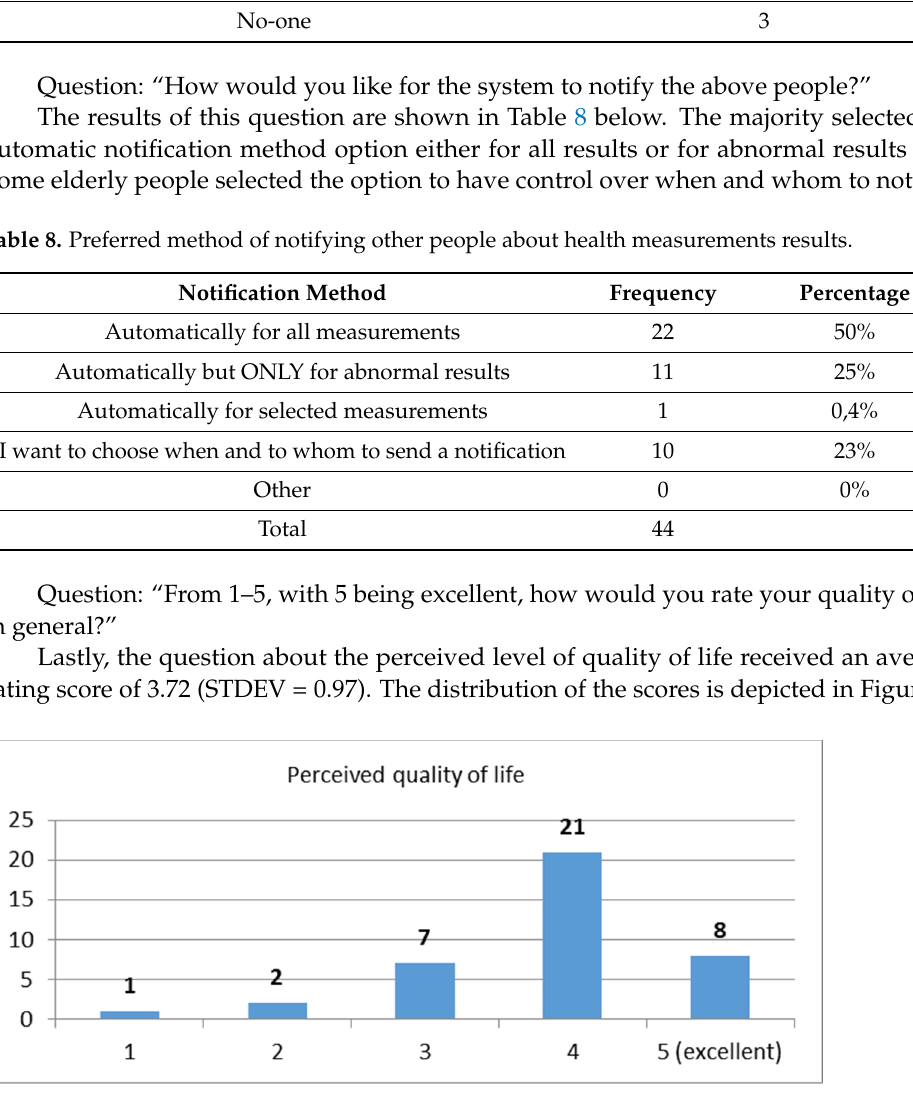
Figure 3. Perceived quality of life ratings.